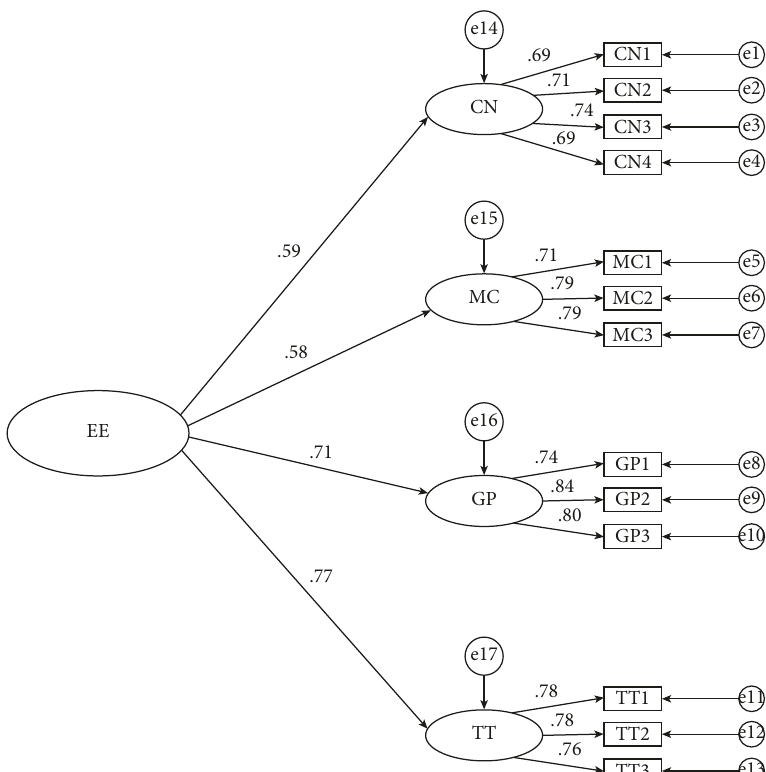
Figure 2: Second-order CFA path analysis chart of external environment scale (standardized).